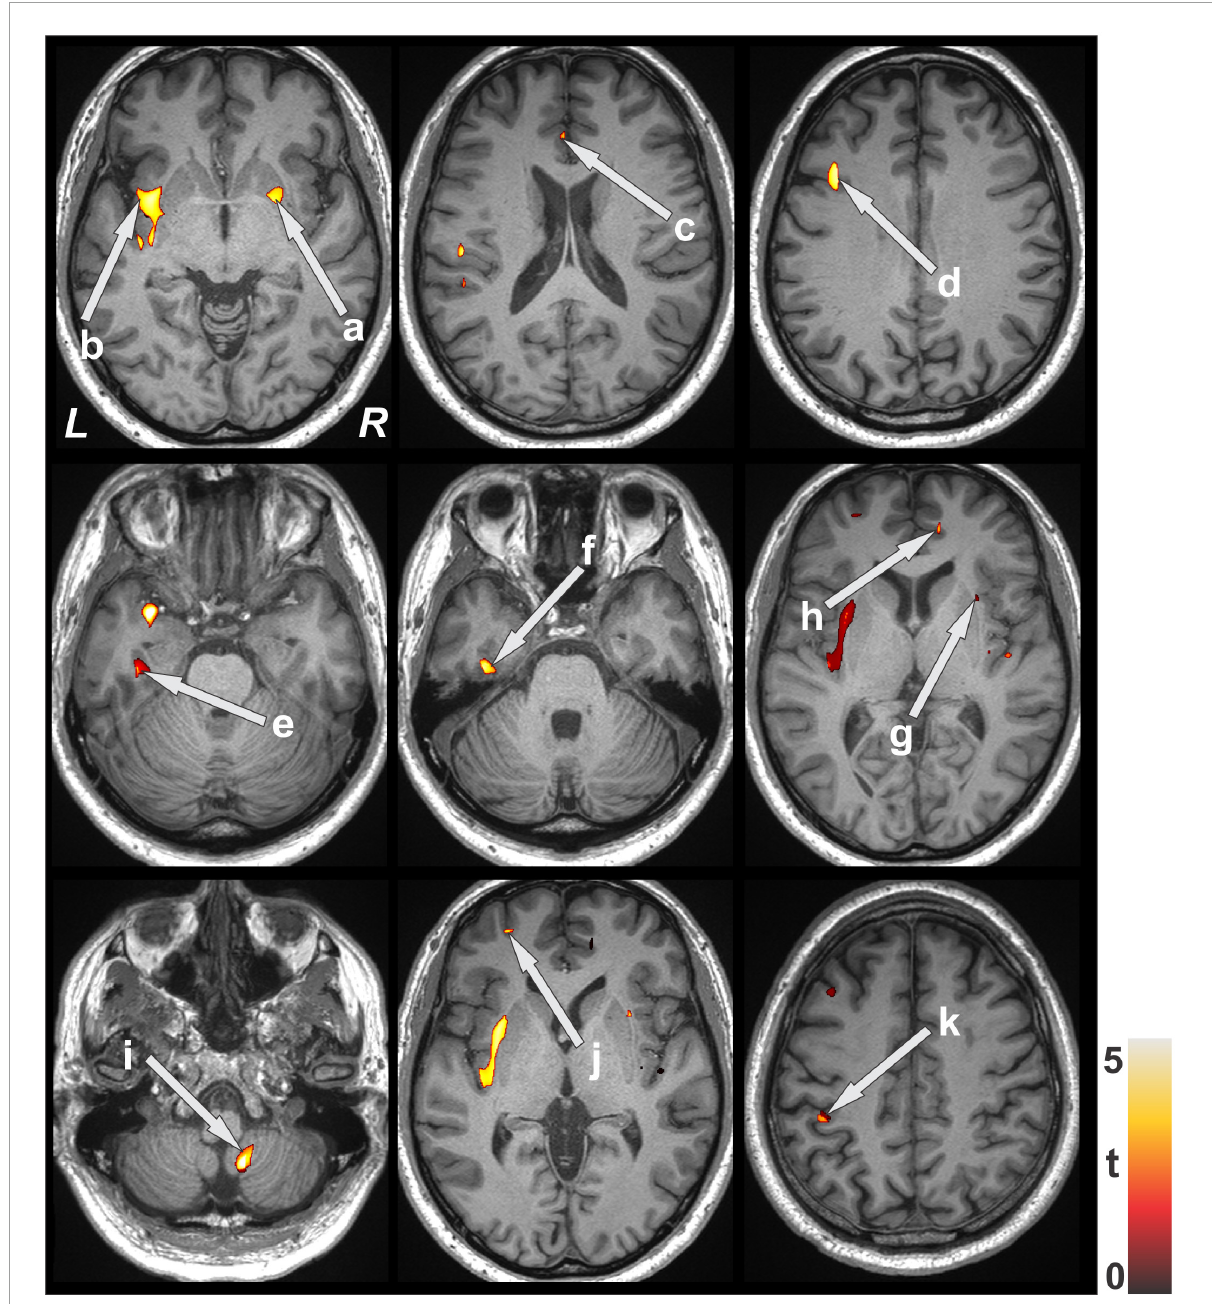
FIGURE1 Brain regions with decreased gray matter volume after lung transplant over pre- lung transplant. Brain clusters with significant GM volume differences between pre- and post-transplant were superimposed onto the background image for structural identification. Sites pointed with arrows showing reduced gray matter volume included the putamen (a), insular cortices (b,g), anterior cingulate (c,h), frontal cortices (d), para-hippocampal gyrus (e), temporal cortices (f), cerebellum (i), prefrontal cortices (j) and parietal cortices (k). All images are in neurological convention (L, left; R, right). Color bar indicates t-statistic